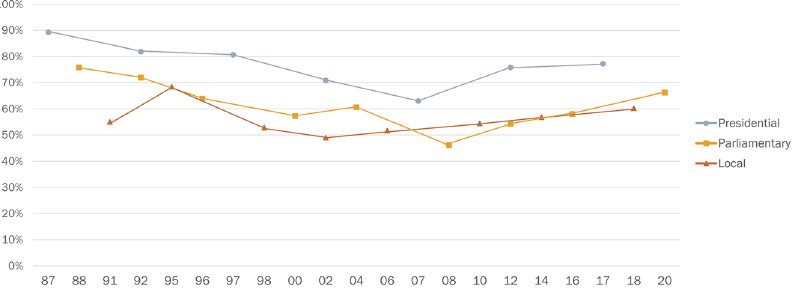
Figure 1: Voter turnout in different levels of elections in South